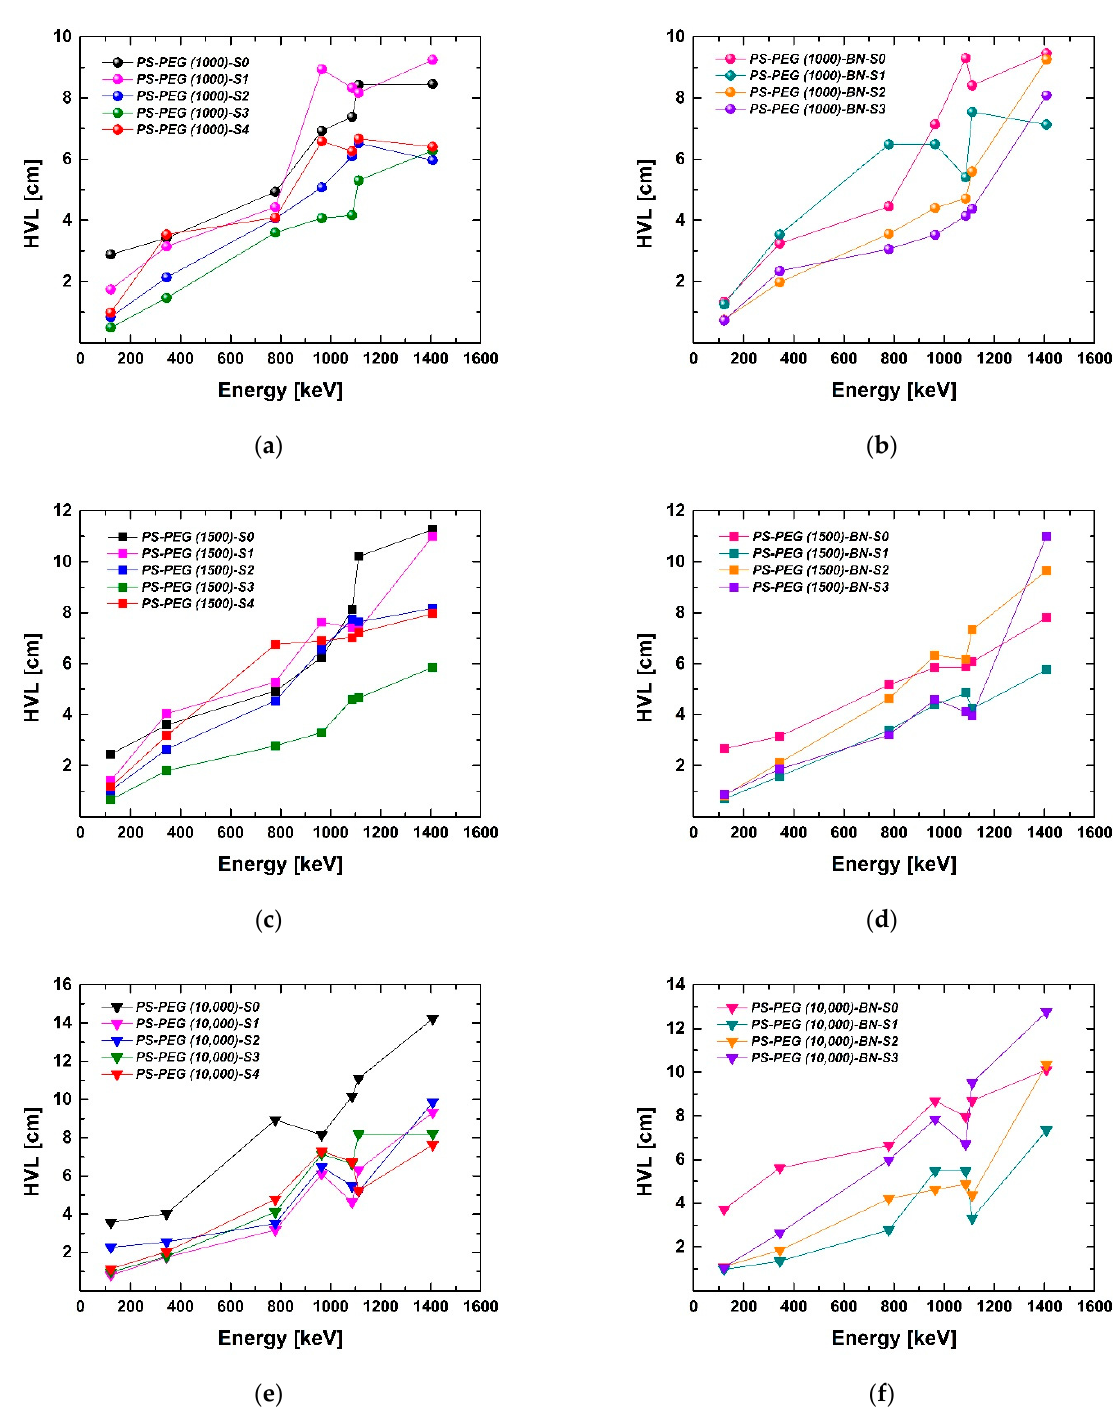
Figure 8. The HVL values of the PbO doped the crosslinked PS-b-PEG block copolymers and the PbO doped the PS-b-PEG-BN nanocomposite materials at different gamma radiation energies (from 121.782 keV to 1408.006 keV) of 152 Eu : ( a ) PS-PEG (1000)-S0,S1,S2,S3,S4; ( b ) PS-PEG (1000)-BN-S0,S1,S2,S3; ( c ) PS-PEG (1500)-S0,S1,S2,S3,S4; ( d ) PS-PEG (1500)-BN-S0,S1,S2,S3; ( e ) PS-PEG (10,000)-S0,S1,S2,S3,S4; ( f ) PS-PEG (10,000)-BN-S0,S1,S2,S3.